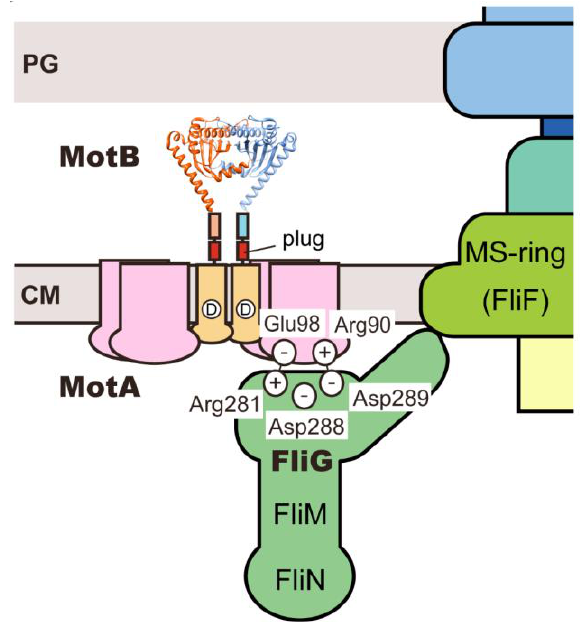
Figure 7. S chematic diagram of interactions at the rotor–stator interface. FliG is postulated to occupy the upper part of the C ring. The interactions between MotA-Arg90 and FliG-Asp289 and between MotA-Glu98 and FliG-Arg281 are directly involved not only in torque generation but also in stator assembly around the